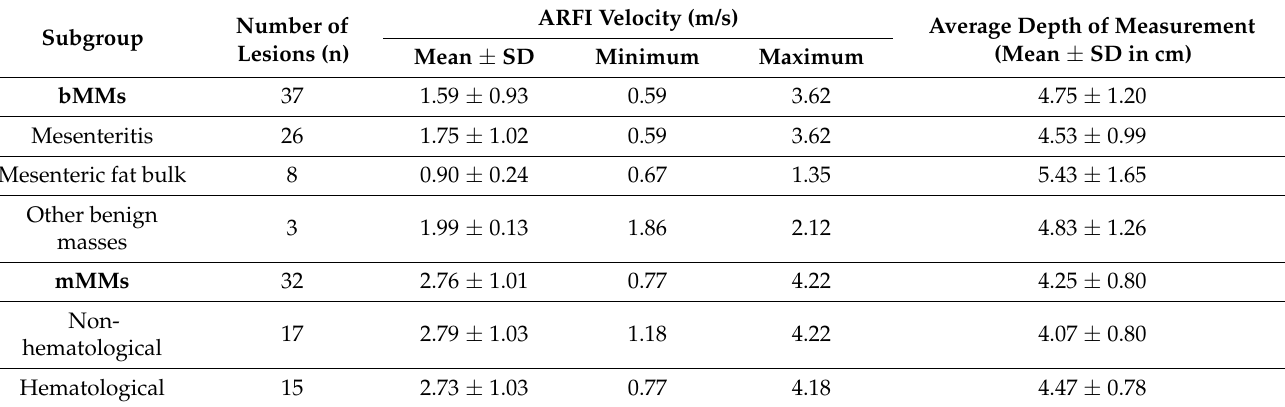
Figure 5. Receiver operator characteristic curve for the differences in mean acoustic radiation force impulse velocities between benign and malignant mesenteric masses. Table 2. Comparison of acoustic radiation force impulse (ARFI) data in different benign and malignant mesenteric masses in n = 69 study patients.